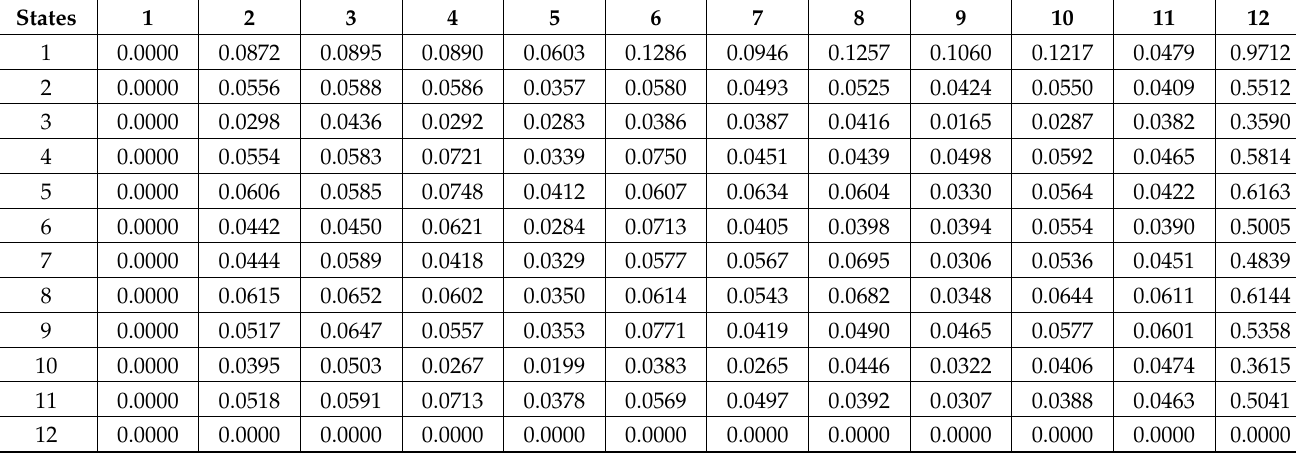
Table 5. Probability matrix f jk for the proposed instance. Note that g kk = 0, ∀ k . Source: Authors’ own elaboration.